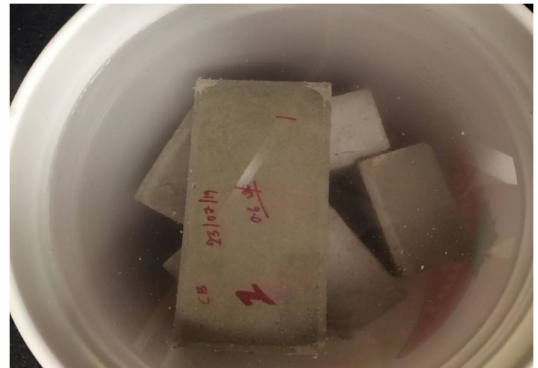
Figure 3. Immersed bricks for the water absorption test.